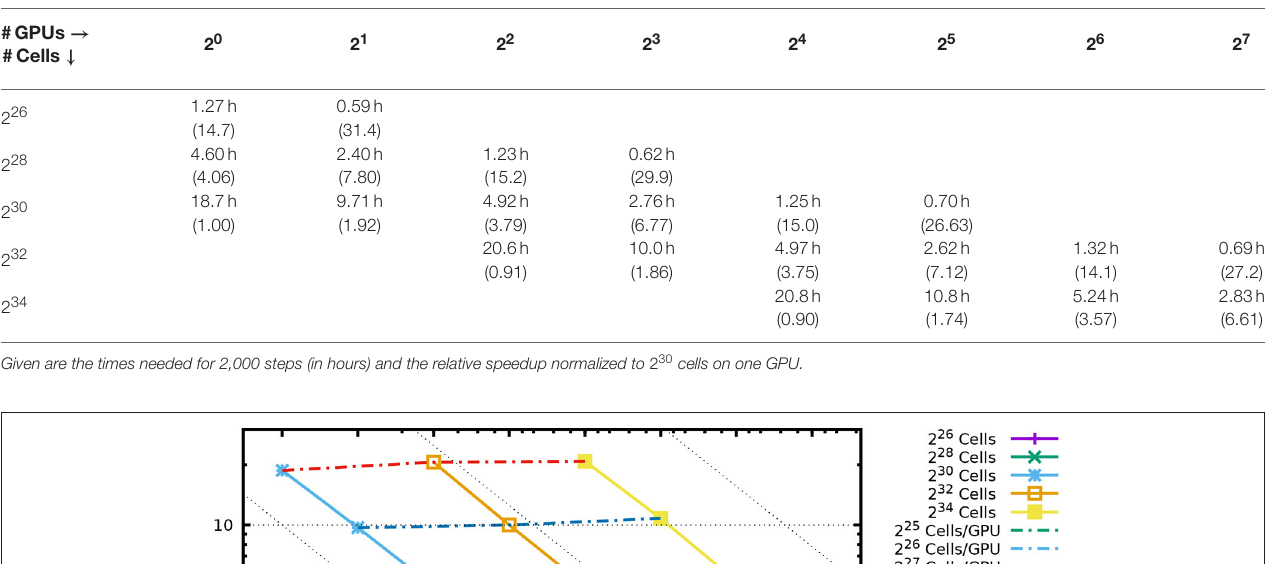
TABLE 1 | Scaling behavior of muphy on JURECA across different problem sizes (absolute number of grid cells) and number of GPUs.